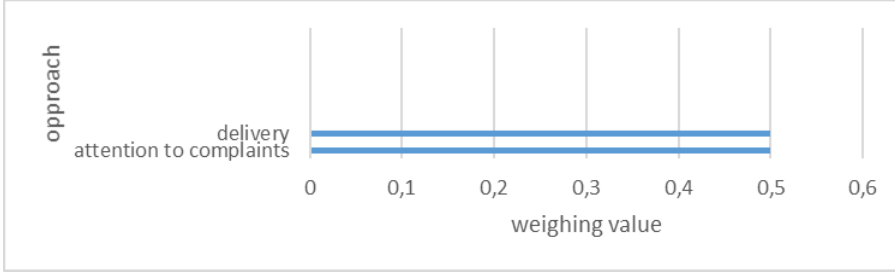
Figure 8: Result of services after sale criteria weighing value (Inconsistency ratio=0.00)